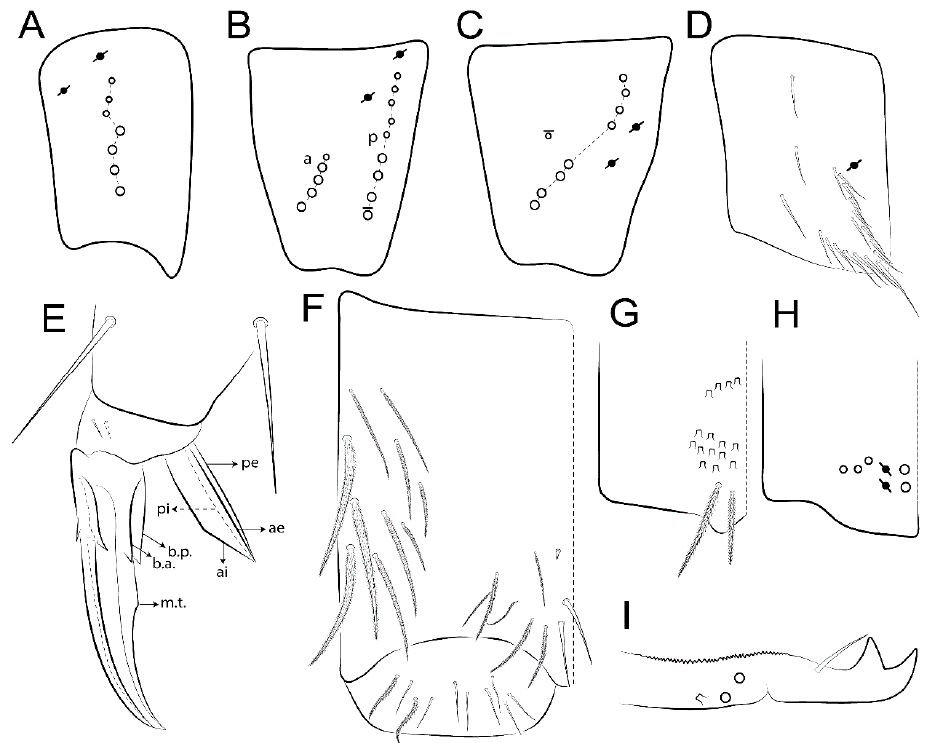
Figure 77. Pseudosinella phyllunguiculata sp. nov.: ( A–C ) subcoxa I–III, respectively; ( D ) trochanteral organ; ( E ) distal tibiotarsus and empodial complex III (anterior view); ( F ) collophore (lateral view); ( G ) distal part of manubrium (ventral view); ( H ) manubrial plate (dorsal view); ( I ) distal dens and mucro (outer view).